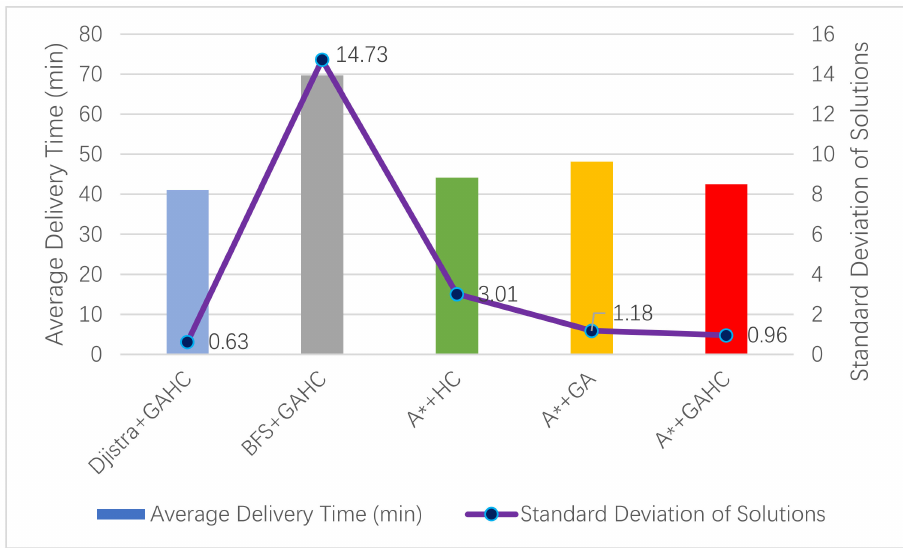
Figure 18. Standard deviation of solutions in various algorithms.